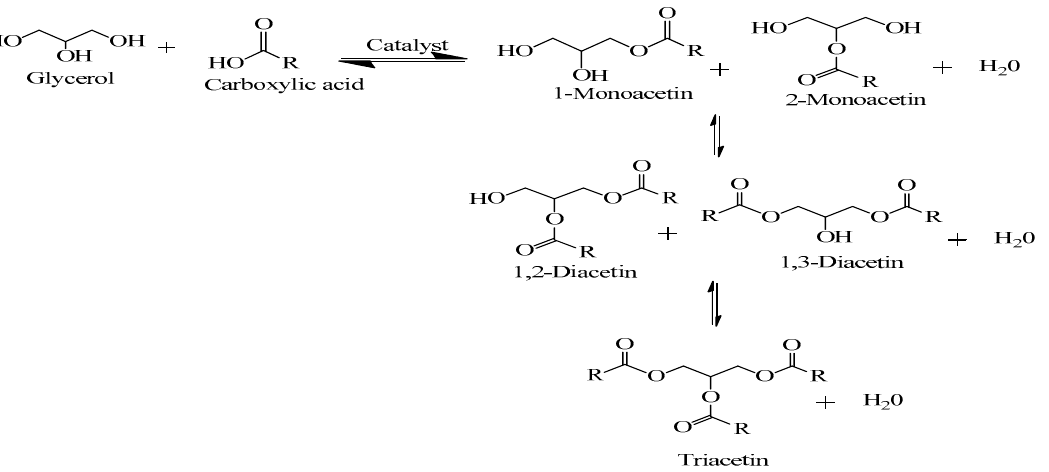
Scheme 4. Conversion of glycerol to acetin by esterification with carboxylic acid.